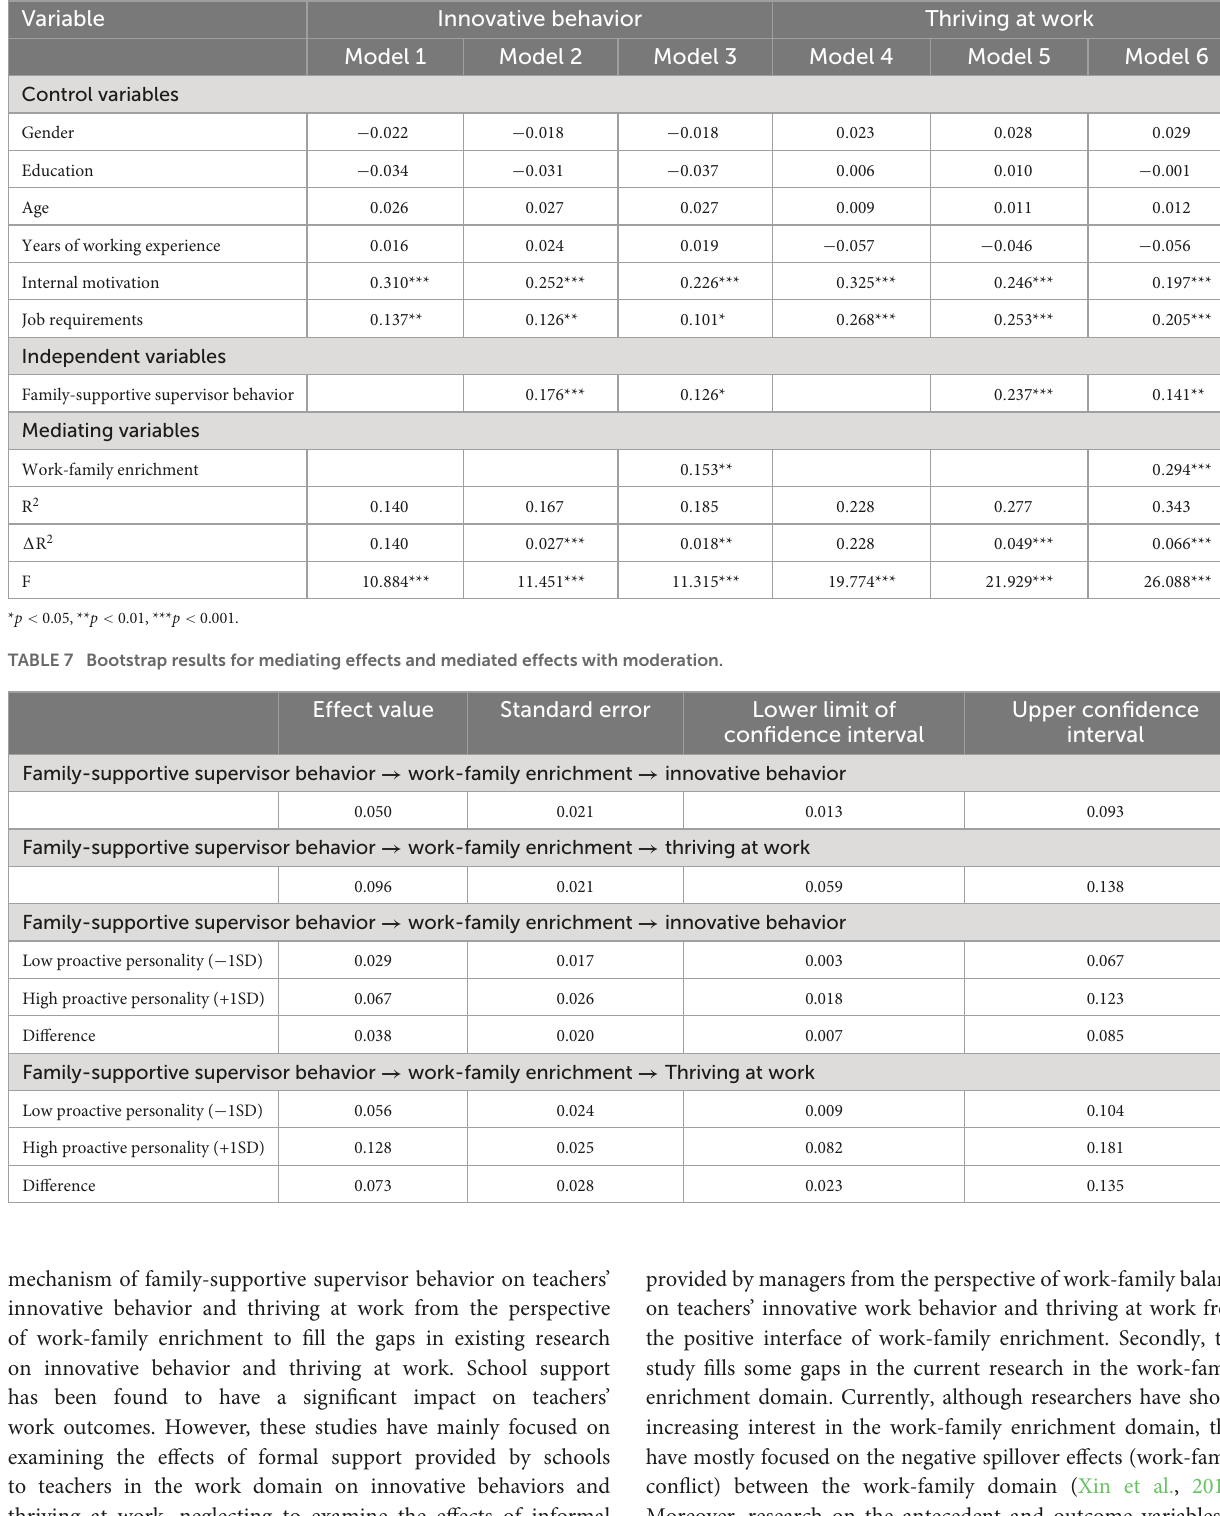
TABLE 6 Test results of hierarchical regression analysis (with work-family enrichment as the dependent variable).